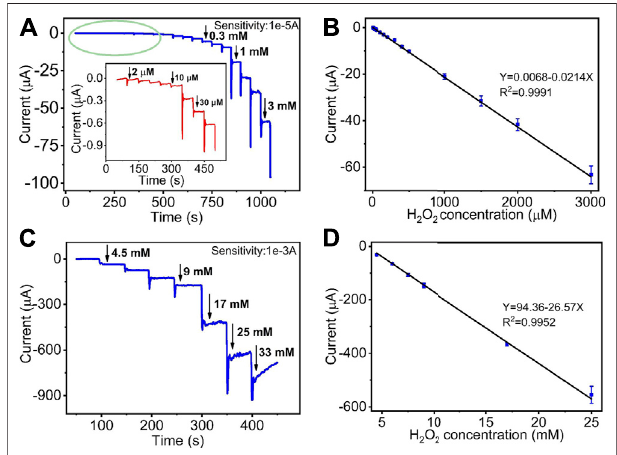
FIGURE 5 | (A) I-t curve of HKUST-1/GCE to the successive addition of low concentration of H 2 O 2 in 0.1 M N 2 statured PBS at − 0.5 V. The inset showsamagni fi edimageoftheI-tcurveoflowconcentrationfrom2to40 μ M. (B) The linear relationship of the response curve of HKUST-1/GCE with different H 2 O 2 concentrations from 2 μ M to 3 mM (R 2 (cid:2) 0.9991). (C) AmperometricresponsesofHKUST-1/GCEtothesuccessiveadditionofhigh concentration of H 2 O 2 in 100 mM PBS solution. (D) The linear fi tting program of the reduction peak current of HKUST-1/GCE with different H 2 O 2 concentrations from 3 to 25 mM (R 2 (cid:2)